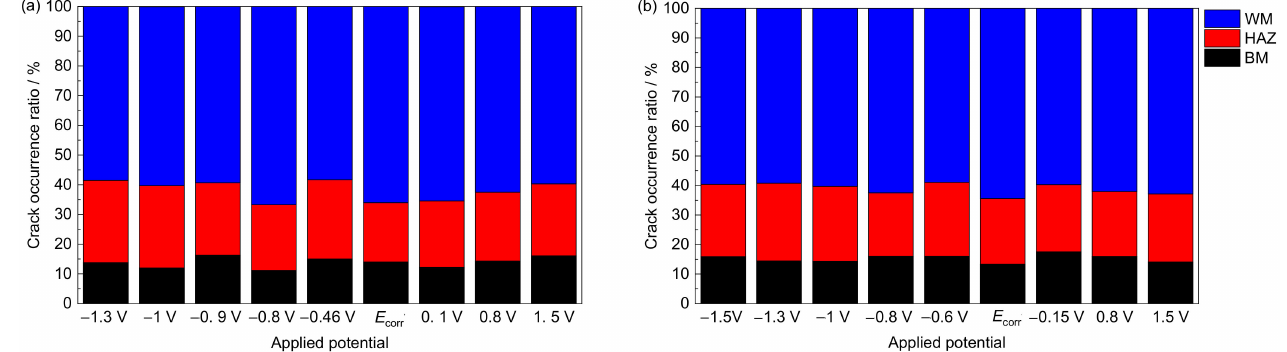
Figure 11. Distribution of secondary crack ratio at various potentials in different areas of welded joints in simulated deep–sea ( a ) and shallow–sea ( b ) environments.